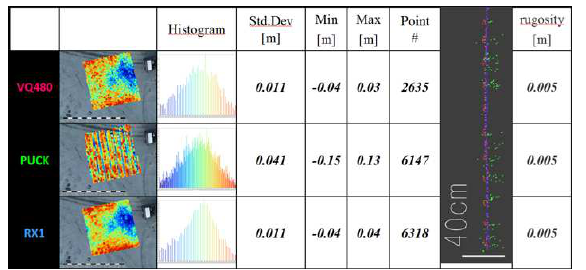
Figure 11: Local variability on a planar surface for different point clouds represented by standard